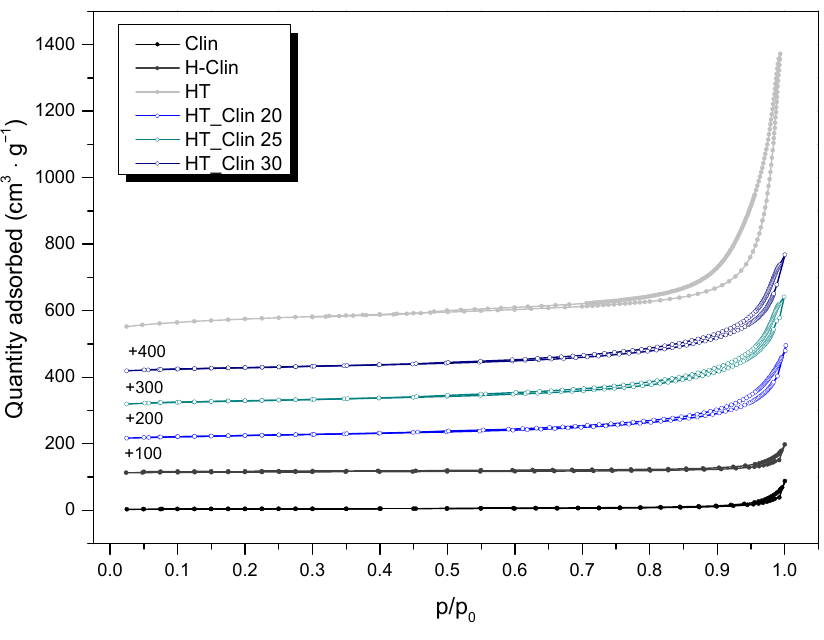
Figure 4. Low-temperature N 2 sorption isotherms obtained for the samples (for better visibility, the isotherms were shifted by the values given in the figure). Table 2. Structural and textural parameters of the investigated